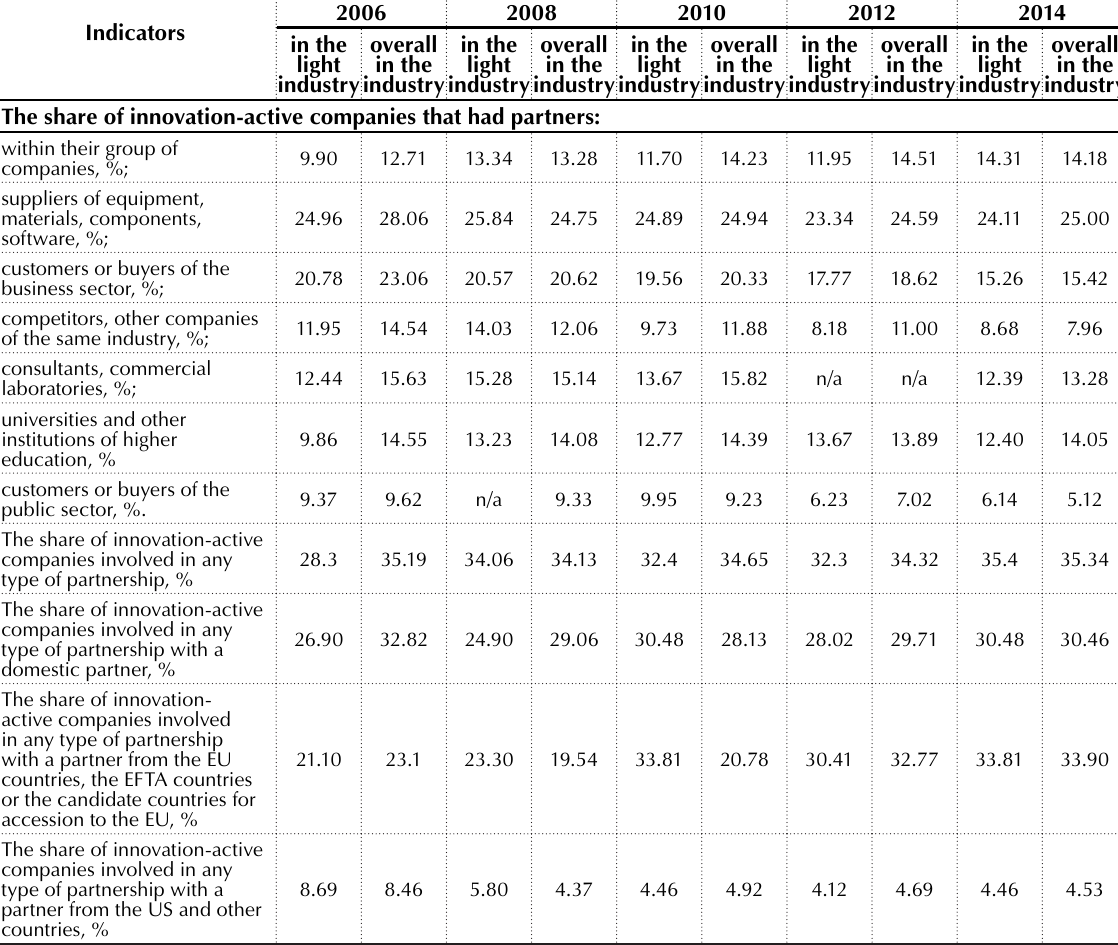
Table 5. The indicators of network innovative cooperation of companies in the EU countries Indicators